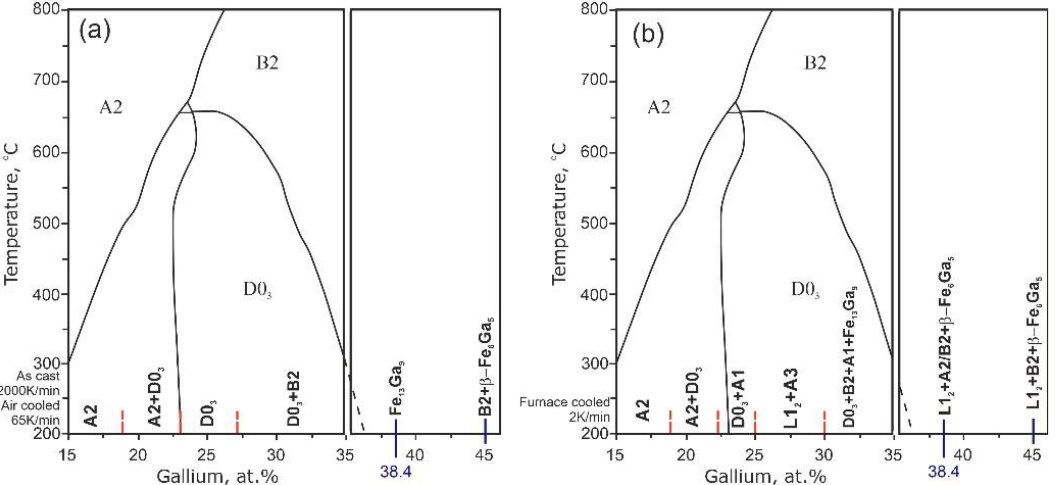
Figure 1. Metastable phase diagram by Ikeda et al. [8] supplied with structures at room temperature by Balagurov et al. [19] for Fe–(15–45)%Ga alloys after casting with a cooling rate ≈ 2000 K/min, cooling in the air at ≈ 60 K/min ( a ), and furnace cooling at 900 °C with 2 K/min ( b ).